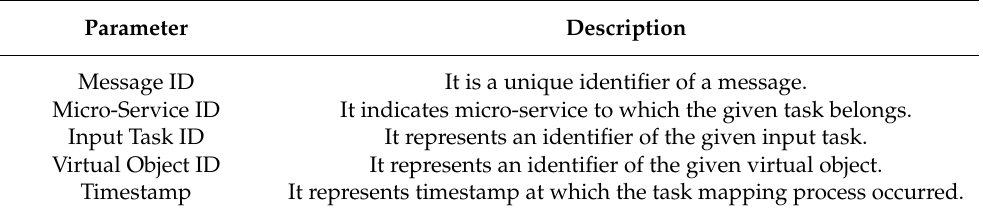
Table 3. Message profile